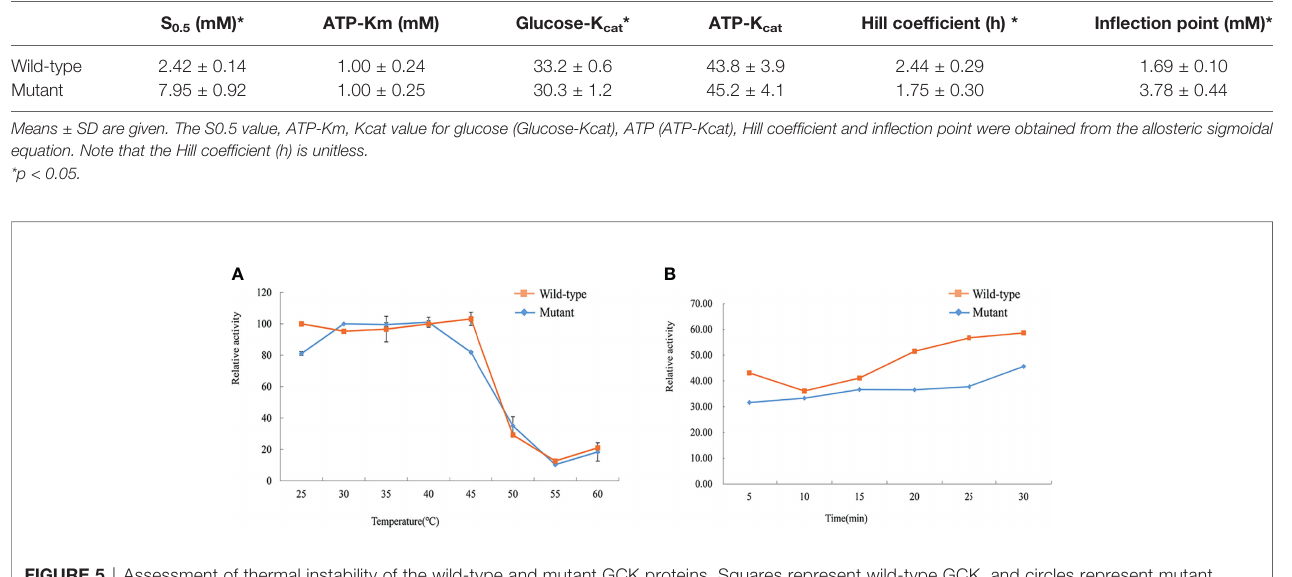
FIGURE 5 | Assessment of thermal instability of the wild-type and mutant GCK proteins. Squares represent wild-type GCK, and circles represent mutant GCK. (A) Relative activity of the wild-type and mutant GCKs at different temperatures in the kinase reaction. (B) Stability of the wild-type and mutant GCKs at 50°C in the kinase